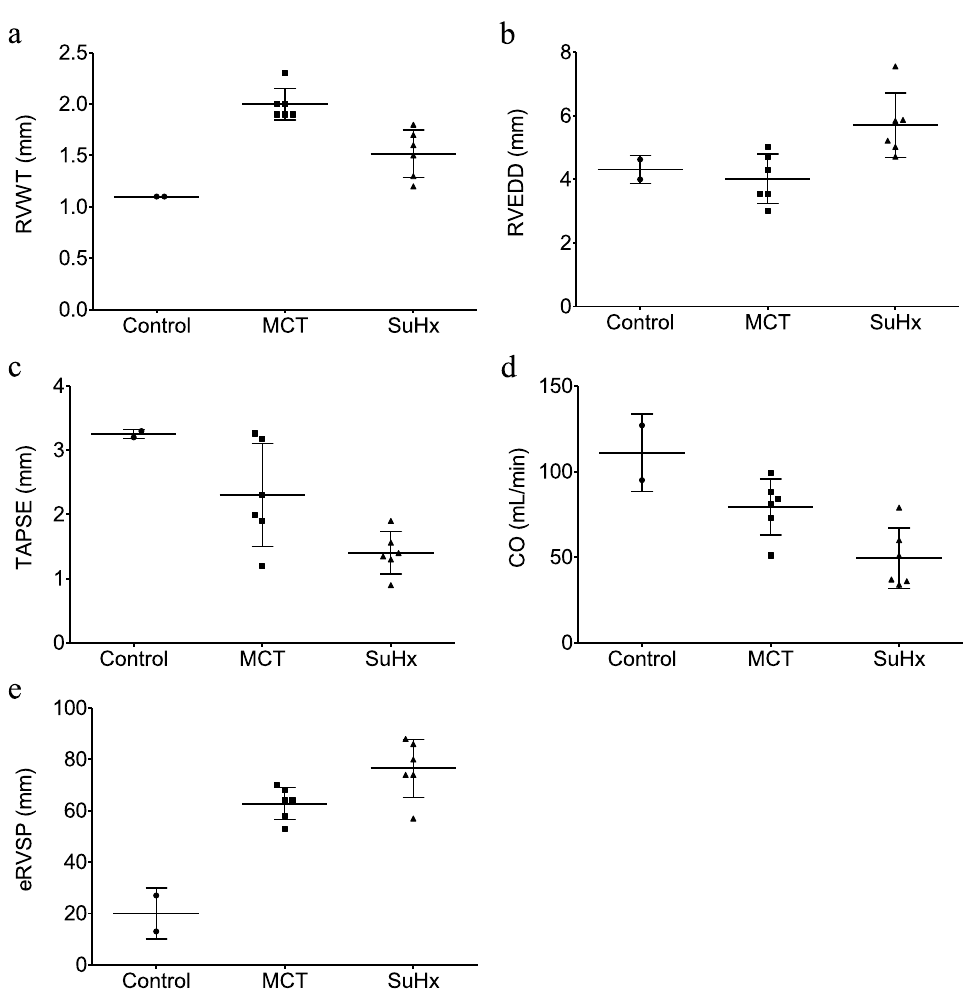
Fig. 7 Echocardiographic parameters in control ( n (RVWT), b right ventricular end diastolic diameter (RVEDD), c tricuspid annular plane systolic excursion (TAPSE), d cardiac output (CO) and e estimated right ventricular systolic pressure (eRVSP)